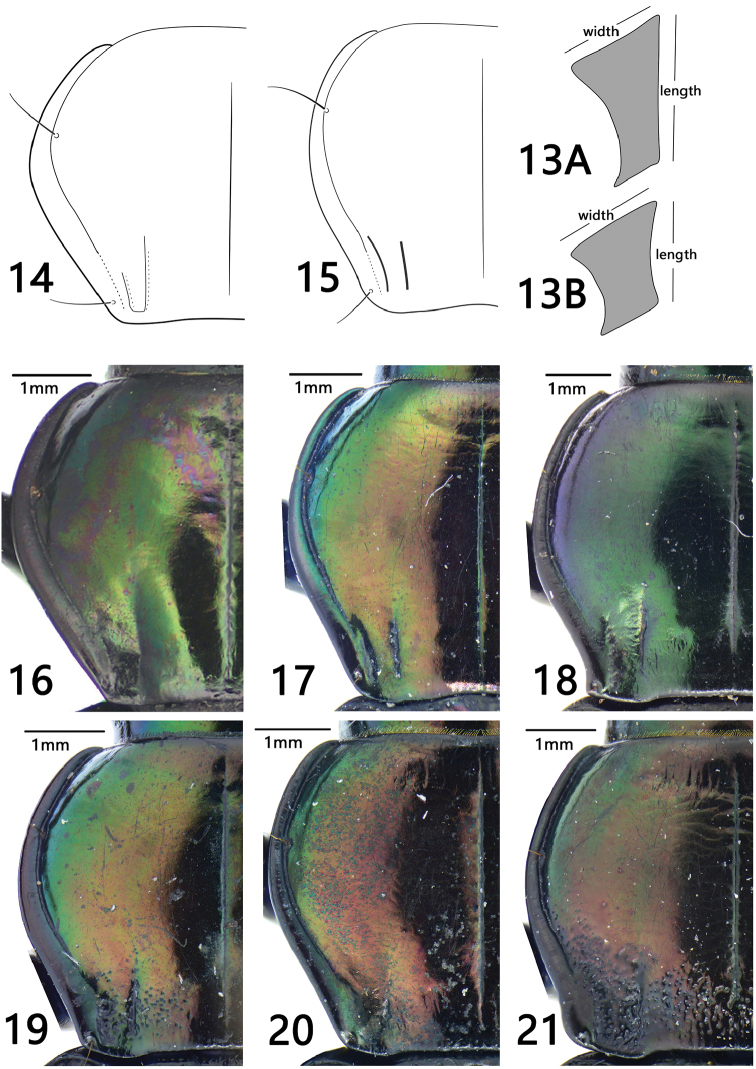
13 Metaepisternum ATrigonotoma
lewisii (long and narrow) BT.
constricta (short and wide) 14–21 pronotum 14, 16T.
constricta15, 17T.
digitata18T.
indica19, 20T.
lewisii21T.
dohrni.